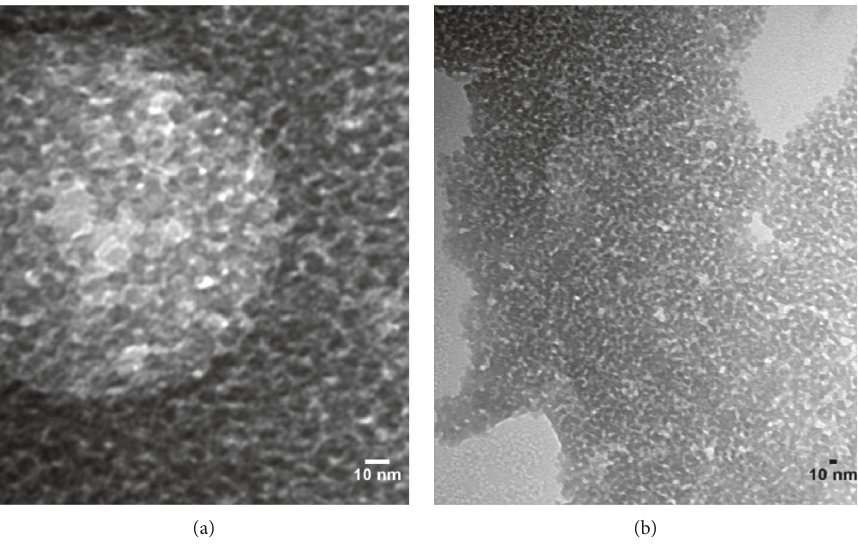
Figure 3: TEM micrograph of LnS at (a) 500,000x and (b) 15,0000x magnification.